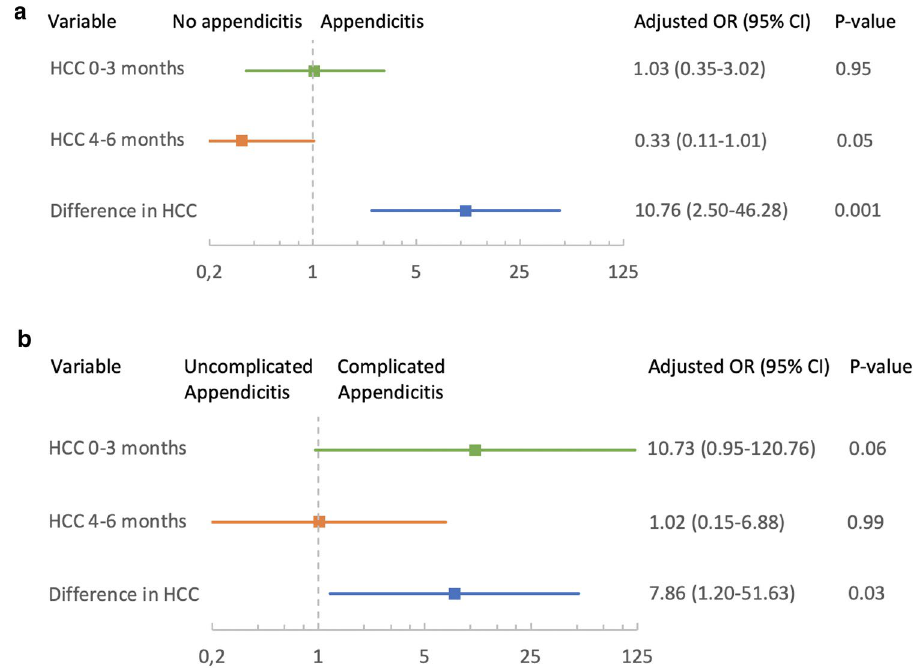
Figure 2. ( a ) Adjusted odds ratio for appendicitis for different timepoints of hair cortisol concentrations in 51 children with appendicitis and 82 controls. n = 106 (66 controls and 40 cases) for HCC 4–6 months and difference in HCC. Adjusted for age, sex and season. ( b ) Adjusted odds ratio for appendicitis for different timepoints of hair cortisol concentrations in 51 children with appendicitis. n = 40 for HCC 4–6 months and difference in HCC. Adjusted for age and sex.